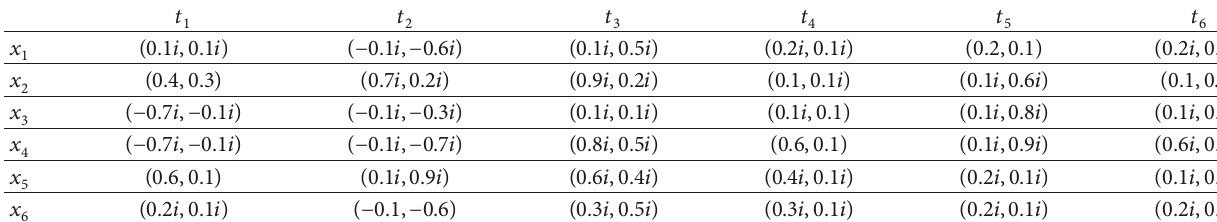
Table 19: The symptoms of case L 1 .